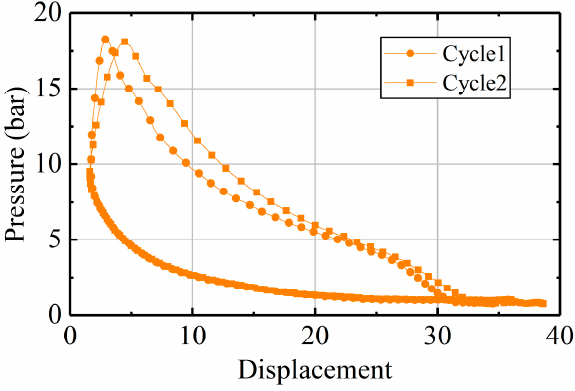
Figure 25. The tested in-cylinder pressure controlled by peak pressure.